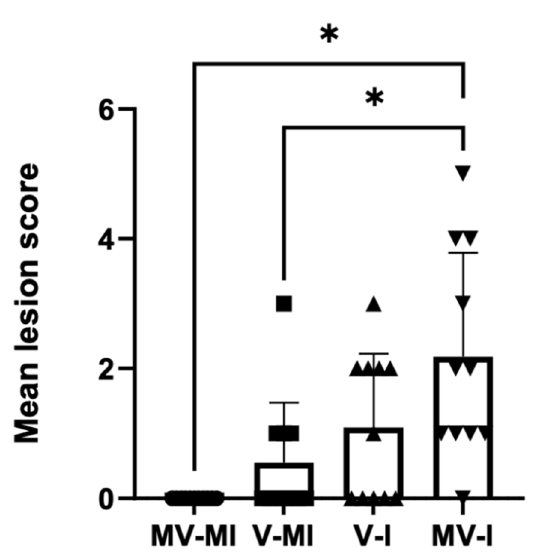
Figure 10. The mean lesion scores are given, and the error bars represent the standard error of means (SEM). Kruskal–Wallis test followed by Dunn’s multiple comparison test was performed to compare mean clinical scores of groups. * = p < 0.05.